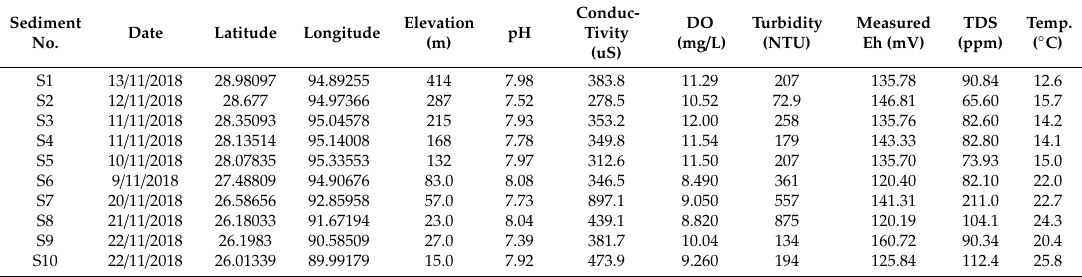
Table 1. Sampling site details and parameters of the Brahmaputra River. Sediment